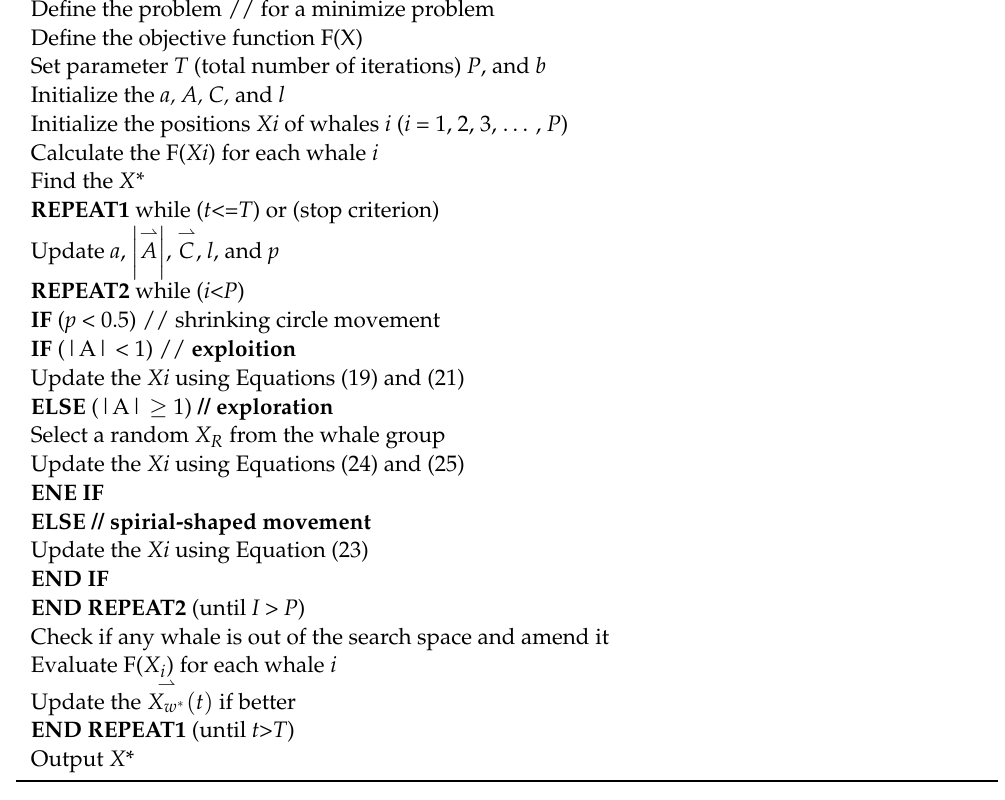
Algorithm A1. The psudo-code of the WOA